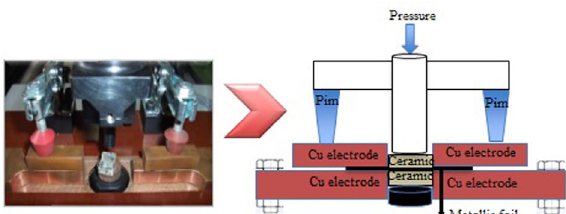
Fig. 1 Schematic representation of the capacitor discharge